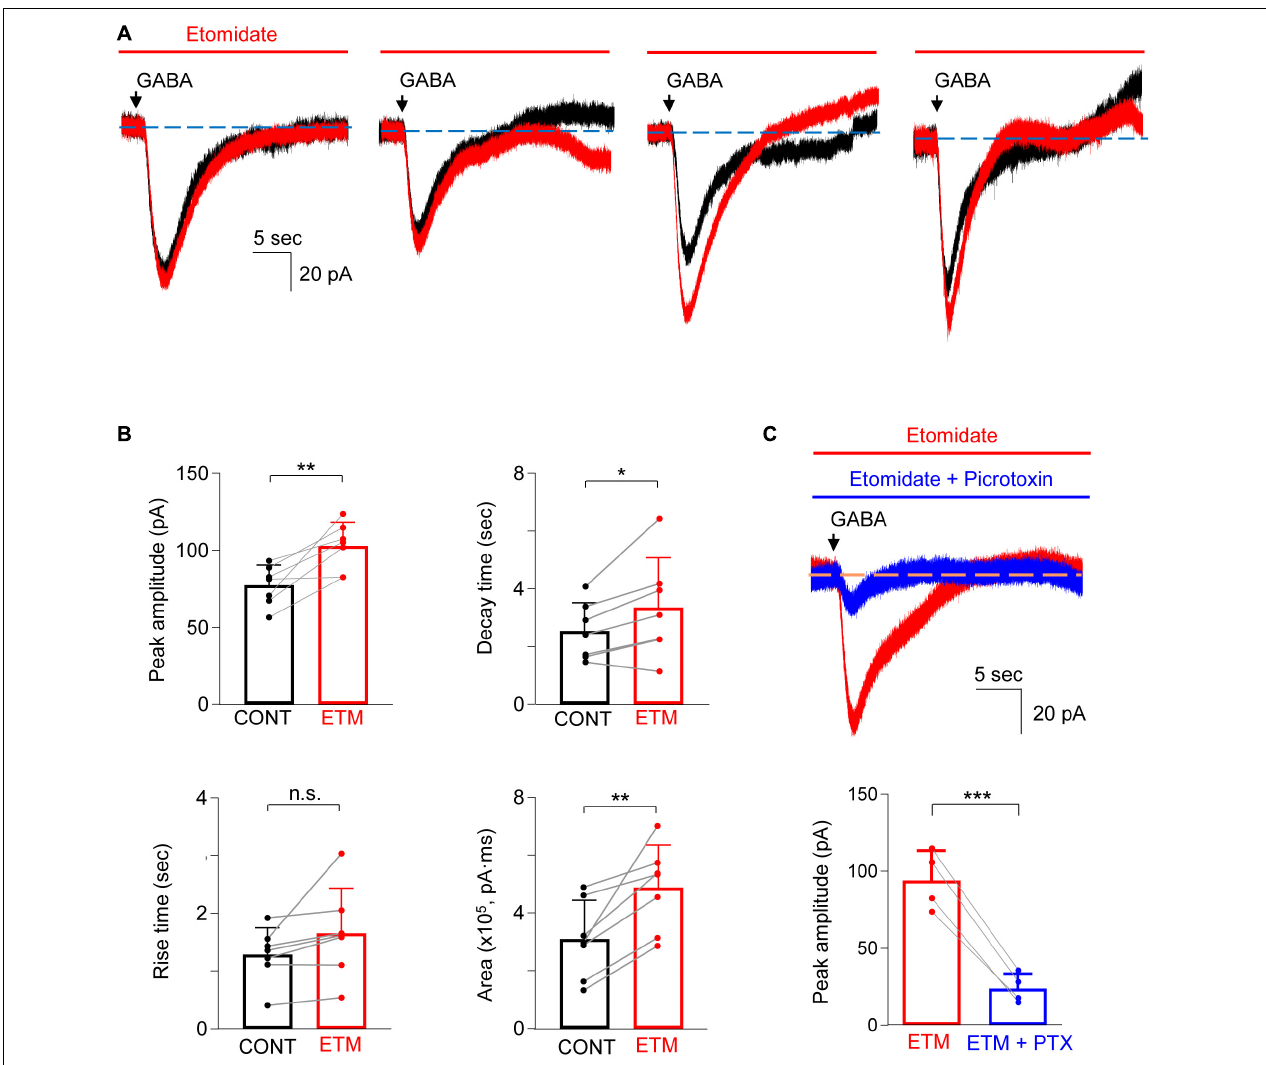
FIGURE 3 | Etomidate potentiated GABA-evoked current in astrocytes. (A) Representative traces show the GABA-evoked responses before and during etomidate (ETM) treatment from four different astrocytes. Note the different shapes of the late phase of the current decay in both the absence and the presence of etomidate. (B) Summarized data for peak amplitude, rise time, decay time, and charge transfer (area). n = 7, * P < 0.05, ** P < 0.01, n.s.: not significant, paired Student’s t -test. CONT: control. (C) Representative traces (top) and summarized data (bottom) show that GABA-evoked current in the presence of etomidate (ETM) is inhibited by picrotoxin (PTX, 0.5 mM, 5–10 min). n = 4, *** P = 0.001, paired Student’s t -test. Data are presented as mean ±